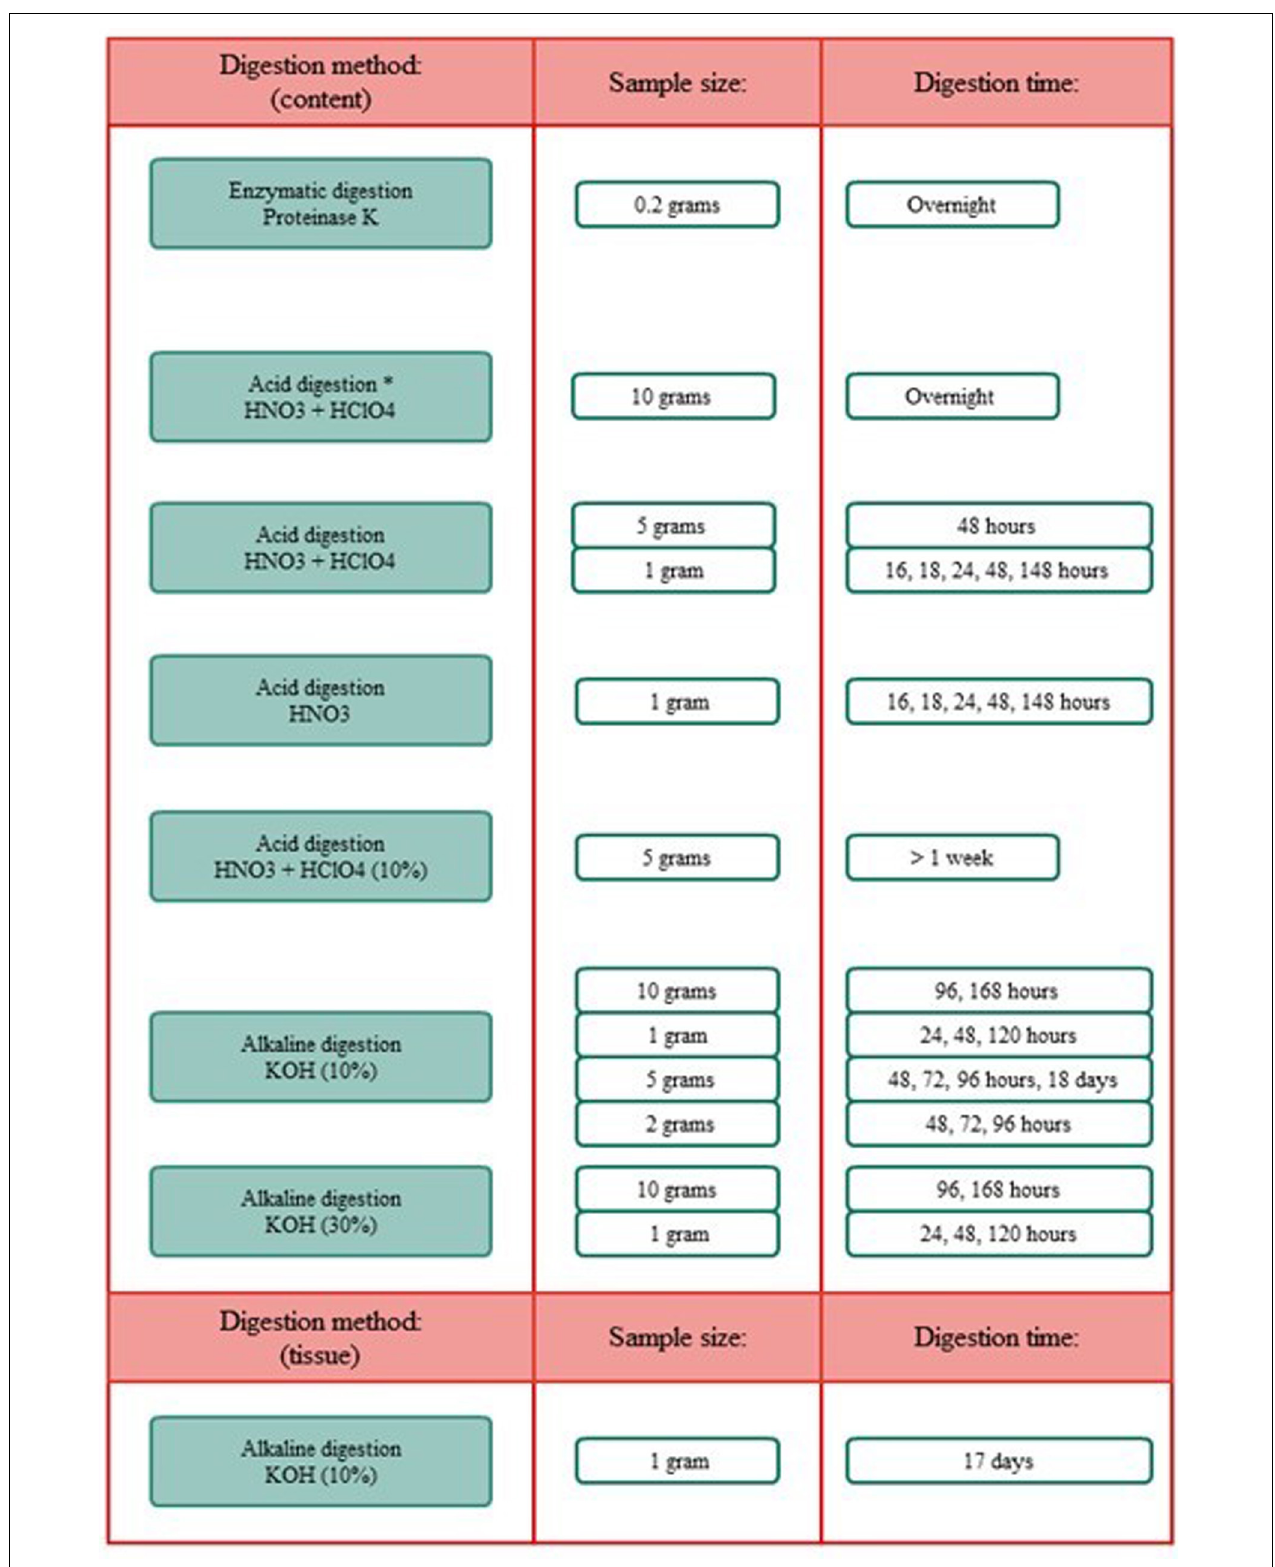
FIGURE 4 | Overview of the different digestion methods, sample sizes, and digestion time frames. *Included boiling.